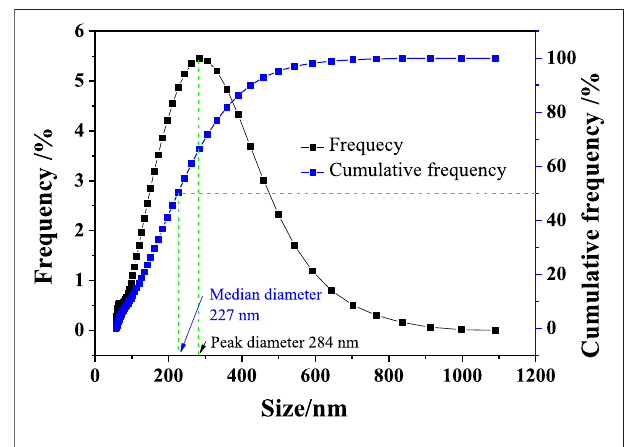
FIGURE 1 | Size distribution curve of